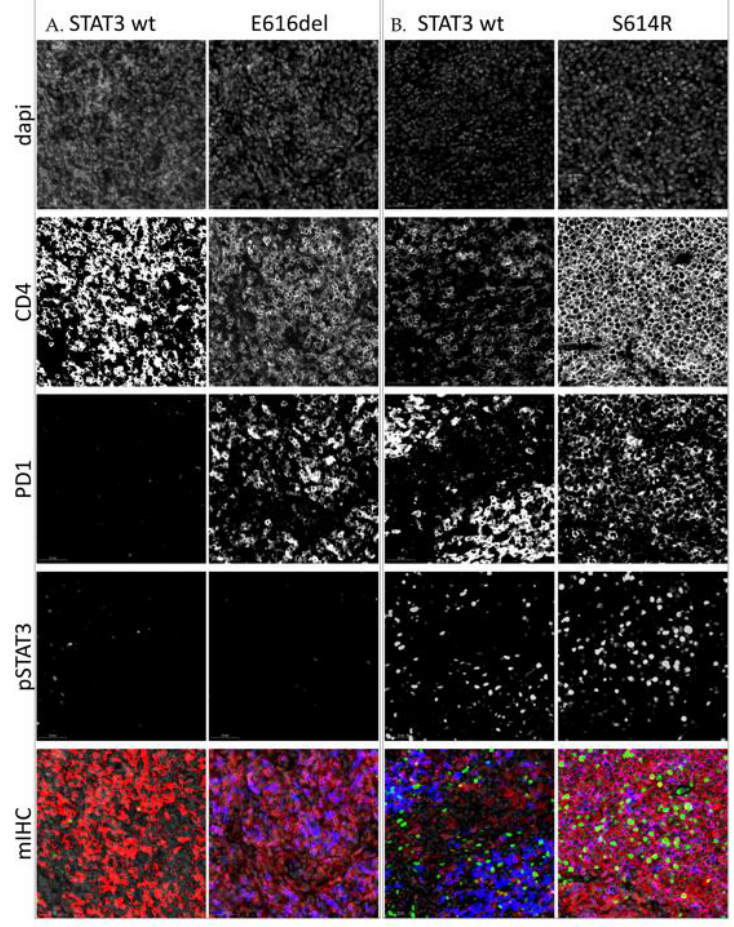
Figure 5. IHC stainings of four angioimmunoblastic T-cell lymphoma (AITL) lymph node samples. ( A ). Samples containing low amount of pSTAT3. ( B ). Samples containing high amounts of pSTAT3. Each slide has been digitalized with a 20× lens and similar exposure time per channel. Images have been further magnified 30× for visualization purposes. The first four rows of images represent single stainings of dapi counterstain, CD4, PD1, and pSTAT3 (Tyr705), respectively, and the last figure their composite image. Staining: red = CD4, blue = PD1, green =